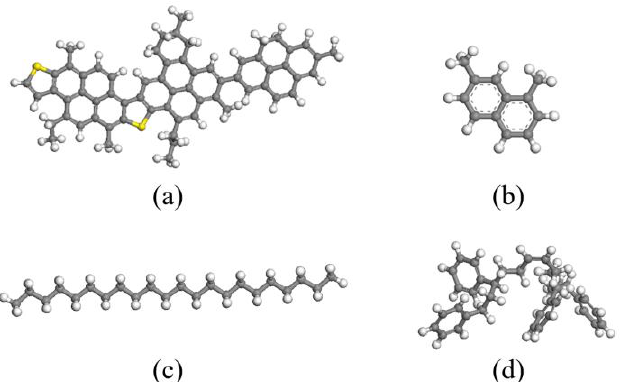
Figure 1. Molecular structures of SBS modified asphalt compositions for molecular simulations: ( a ) asphaltene; ( b ) naphthene aromatic; ( c ) saturate; ( d ) SBS.